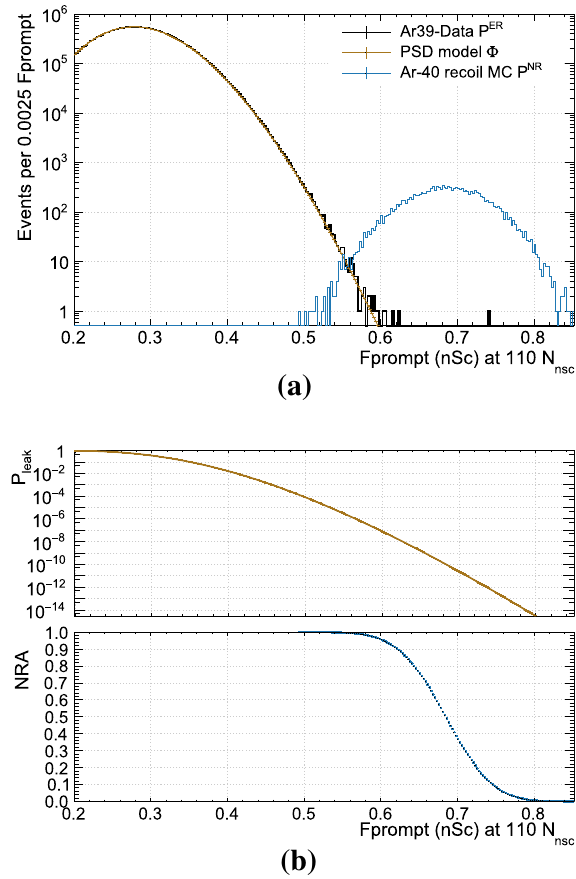
Fig. 4 a The F nsc N nsc are shown for 39 Ar β prompt distributions at 110 events(background),togetherwiththemodelfit,andforsimulated 40 Ar recoil events (signal). b The background leakage probability (based on the fit model to 39 Ar data) and signal acceptance (based on signal MC) as a function of the PSD parameter is shown